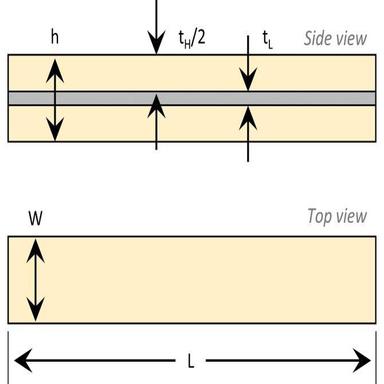
Schematic representation of the interply hybrid composite test coupons. The grey shading indicates a low strain layer and the yellow shading indicates the high strain layers. (For interpretation of the references to colour in this figure legend, the reader is referred to the web version of this article.)